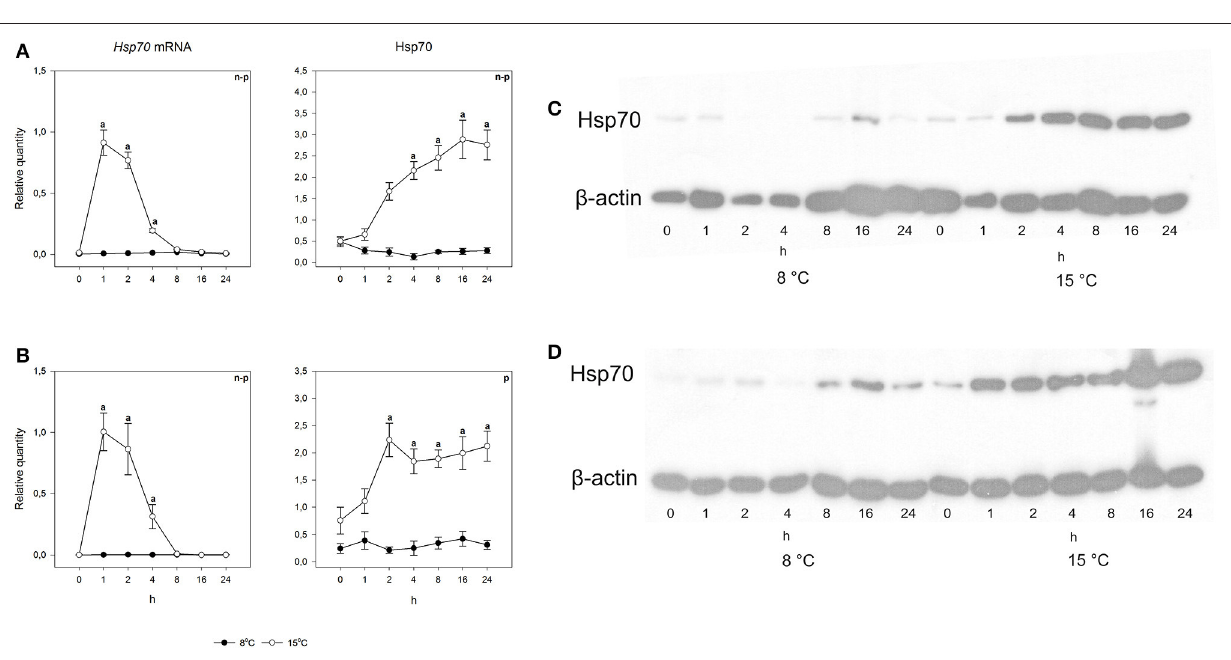
FIGURE 5 | Time course of heat shock induced hsp70 mRNA and protein synthesis in Arctic charr. Relative quantities (mean ± SEM; n = 7) in (A) gills and (B) liver. Relative quantities of hsp70 are based on hsp/ β -actin ratios in the western blots. Representative examples of western blots for gills are given in (C) and liver in (D) . Whenever ANOVA or Kruskal-Wallis on ranks [parametric (p) or non-parametric (n-p), respectively] indicated statistically significant differences post-hoc testing (Dunnett’s method) was conducted. A letter above a symbol indicates that the levels at that time point are significantly different from levels before the heat shock ( p <